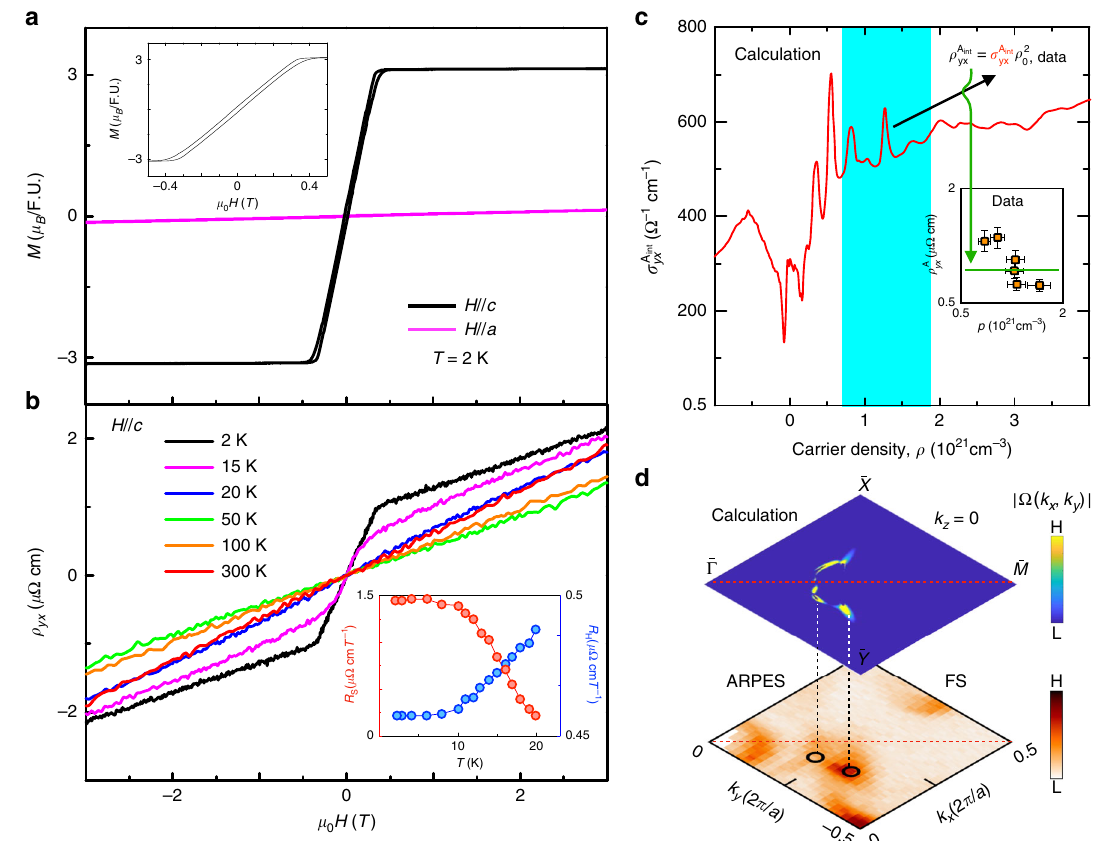
Fig. 5 Observation of intrinsic anomalous Hall transport in PrAlGe. a Magnetization M of PrAlGe along the c -axis (black) and a -axis (magenta) versus magnetic induction μ 0 H . The Curie temperature is observed to be T C = 16 K. Inset: zoom-in showing a hysteresis loop. b Hall resistivity ρ yx as a function of μ H . The inset shows the ordinary and anomalous Hall coef fi cients R R 0 H (blue) and S (red) as a function of temperature extracted from the data. c Ab initio calculated intrinsic anomalous Hall conductivity σ A int yx as a function of carrier density. The shaded turquoise area corresponds to the carrier density of the measured PrAlGe samples. The inset shows the measured anomalous Hall resistivity ρ A yx as a function of carrier density p. The horizontal green line corresponds to the calculated intrinsic contribution to ρ A yx . The error bars are set by the ±10% error in measurement of the sample dimensions. d Surface- bulk-transport correspondence of Weyl fermions in PrAlGe. Top: Berry curvature magnitude ∣ Ω ( k ) ∣ at k z = 0 summed over energies below the Fermi level, from ab initio calculation. Bottom: ARPES-measured Fermi surface, suggesting that the Berry curvature fi eld is concentrated near the termination points of the Fermi arc and projection point of the Weyl cones (open circles) observed in